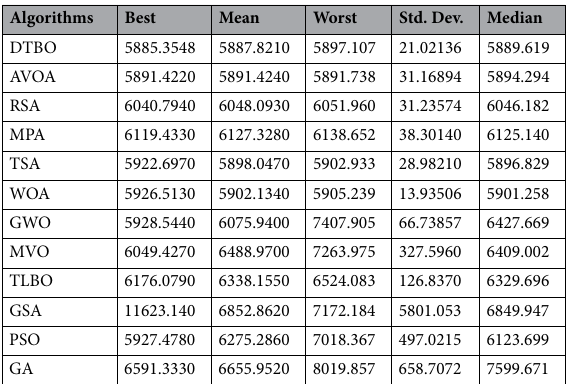
Table 9. Statistical results of optimization algorithms in the design of pressure